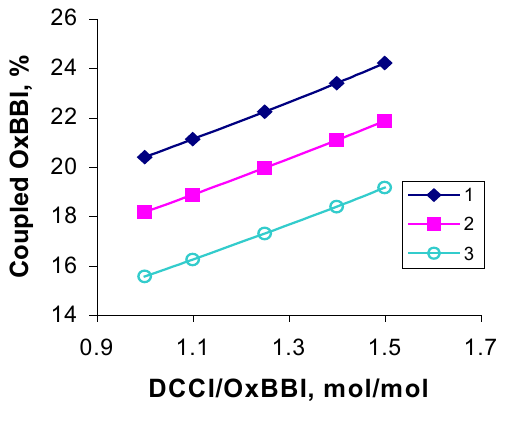
Figure 2. Influence of the dcci/oxbbi molar ratio on the coupled drug ratio, at t=21 hours, 1 – gellan/oxbbi=0.261 mol/mol; 2 – gellan/oxbbi=0.35 mol/mol; 3 – gellan/oxbbi=0.44